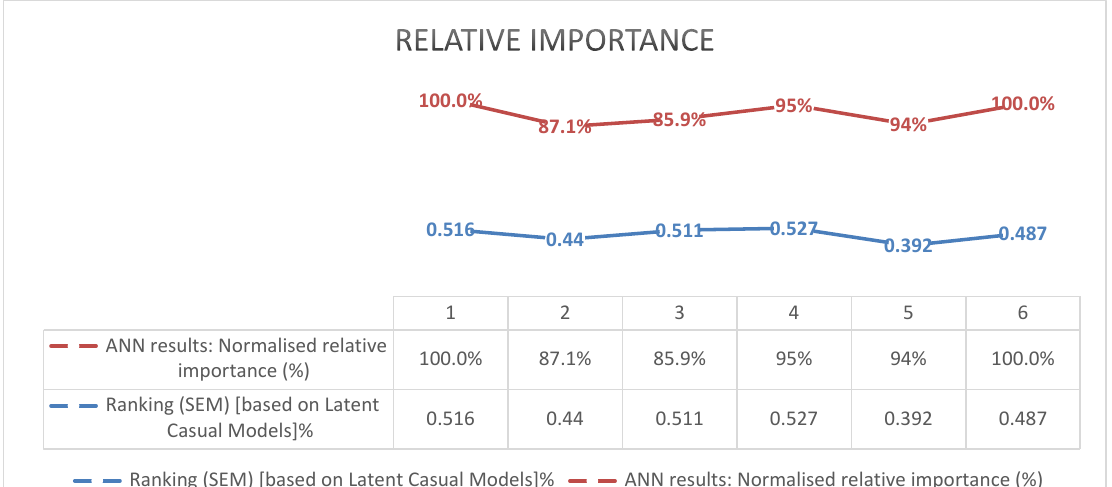
ANN results: Normalised relative importance Fig. 5. Relative Importance